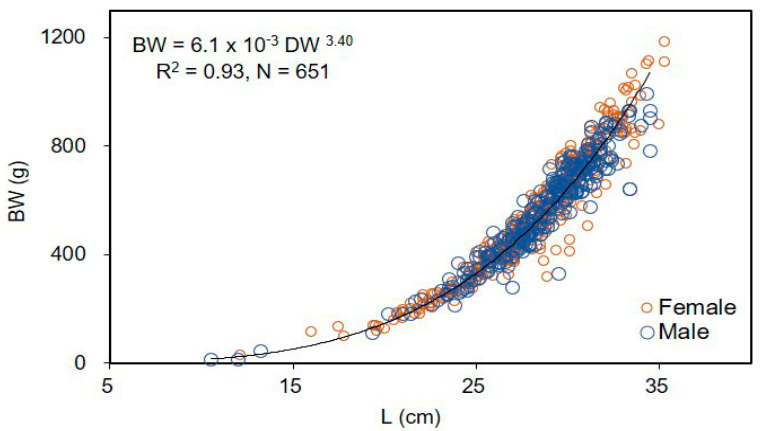
Figure 5. Relationship between body weight ( BW ) and disc width ( L ) of Okamejei kenojei collected from the West Sea of South Korea.